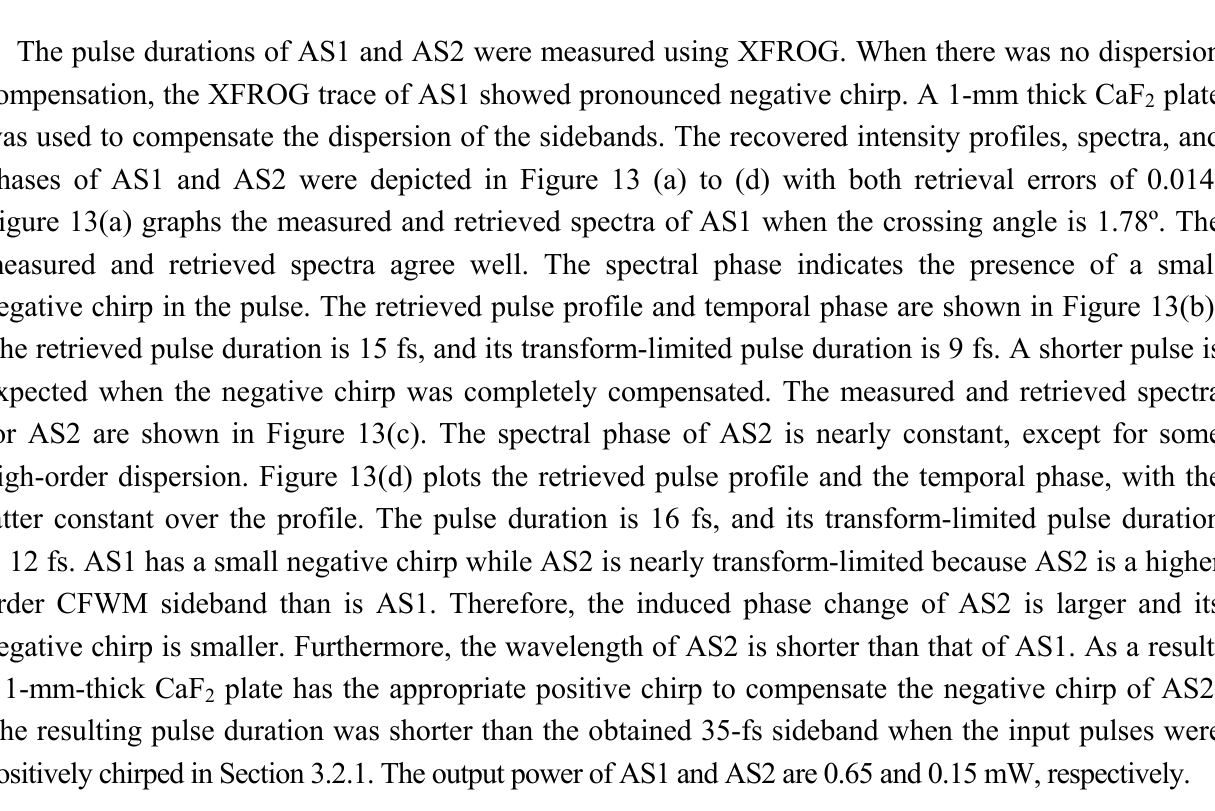
Figure 13. (a) Recovered spectrum (black solid curve), spectral phase (blue solid curve), and measured spectrum (red dotted curve) of AS1. (b) Recovered intensity profile and phase of AS1. The red dotted curve is the transform-limited (TL) (9 fs) pulse profile of AS1. (c) Recovered spectrum (black solid curve), spectral phase (blue solid curve), and measured spectrum (red dotted curve) of AS2. (d) Recovered pulse profile and phase of AS2. The red dotted curve is the TL (12 fs) pulse profile of AS1